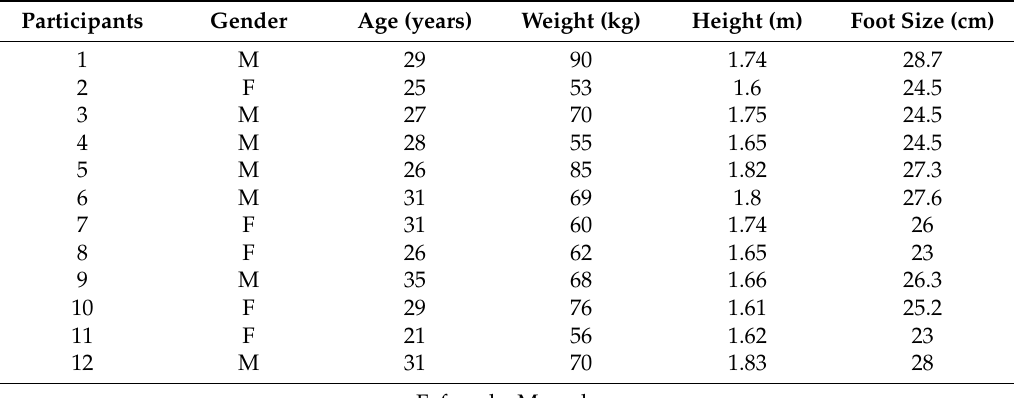
Table 2. Age, gender and anthropometric characteristics of the 12